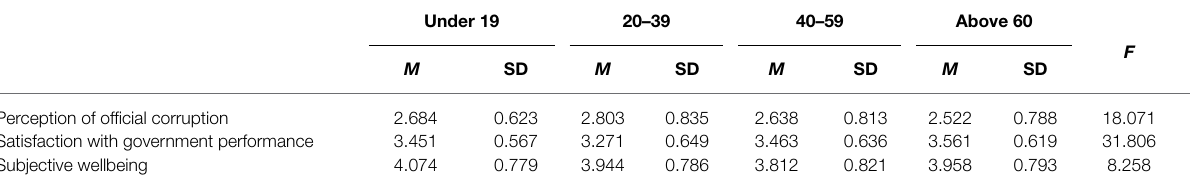
TABLE 2 | The differences of variables between different groups of age.